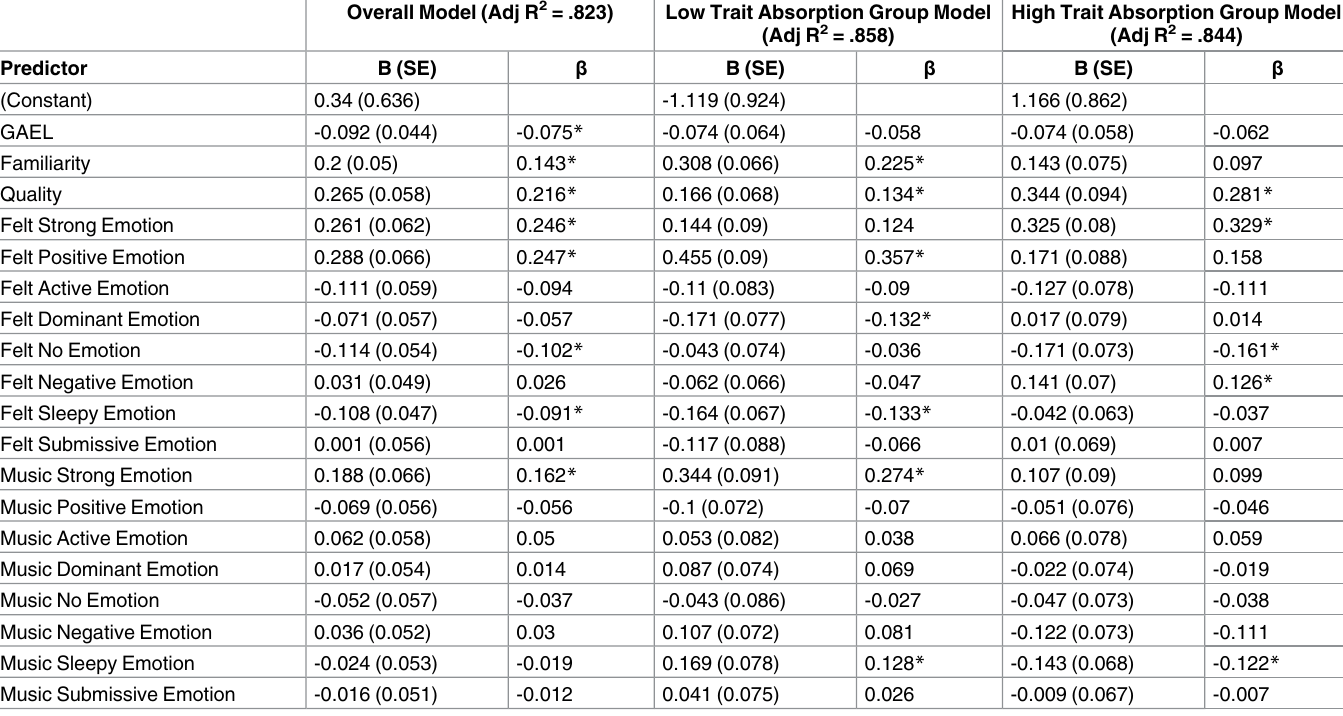
Table 4. Coefficients for three multiple linear regression models for Loved music